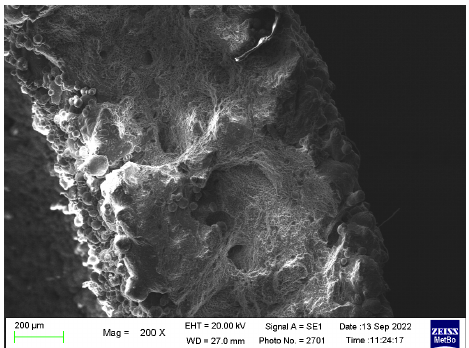
Figure 12. Final fracture surface of a 1.2 mm thick specimen T6